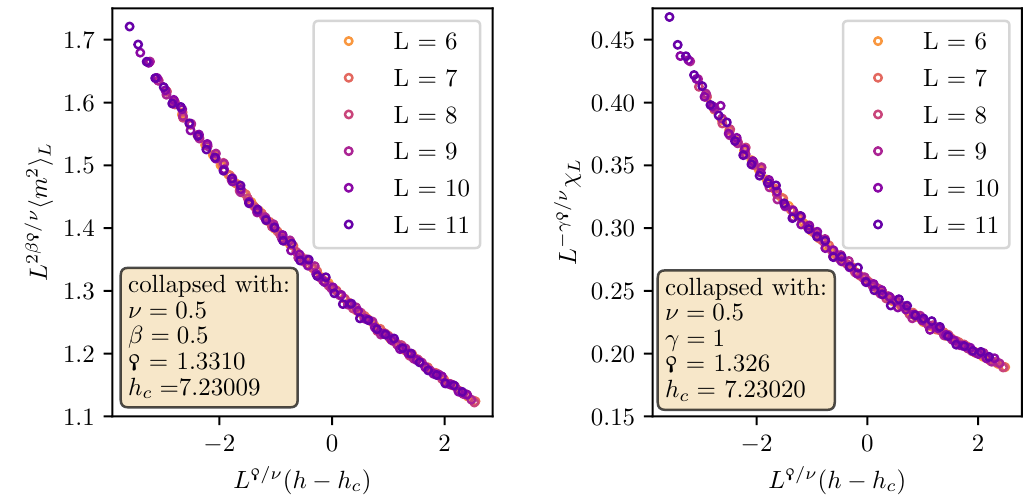
Figure 5: Data collapse of the squared magnetization (left) and the order-parameter susceptibility (right) for the 4d nearest-neighbor TFIM according to Eq. (70). The critical exponents with mean-field values ν = 1 / 2, β = 1 / 2 and γ = 1 were kept fix in the fit. The raw data used for these data collapses is provided in Ref. [ 71 ]